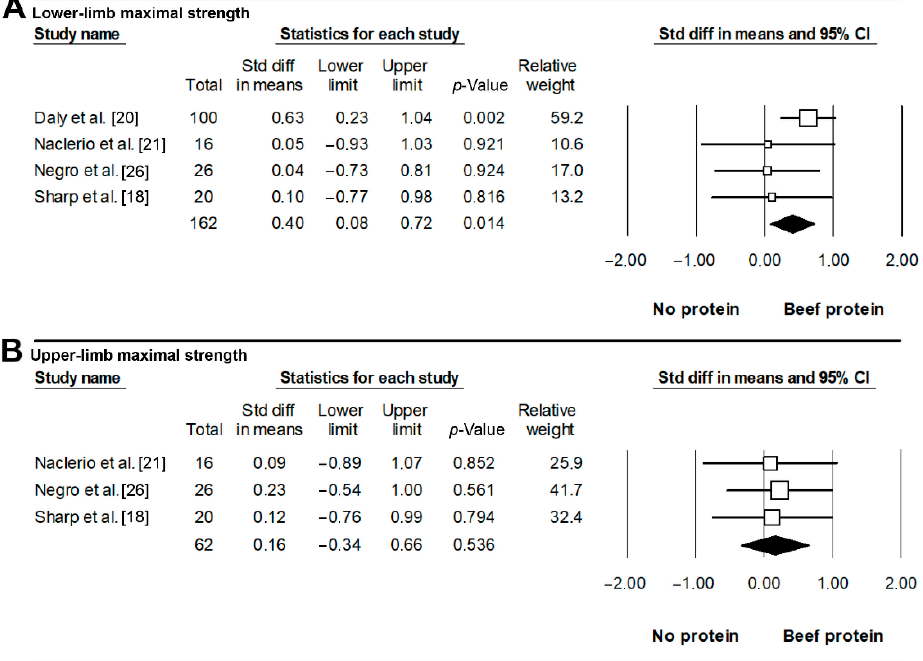
Figure 4. Effects on lower- ( A ) and upper-limb maximal strength ( B ) of beef vs. no protein supplementation. Each forest plot displays the pooled standardized difference in means and 95% confidence interval.